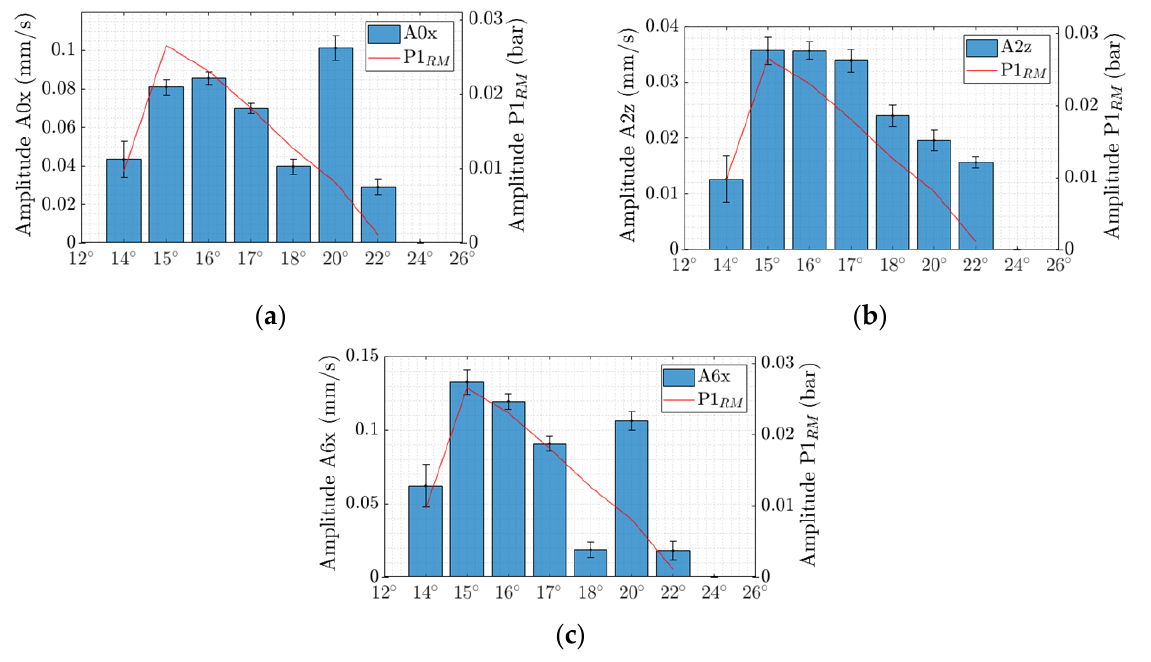
Figure 11. Velocity vibration levels at f rvr on the draft tube in radial direction for position A0x ( a ), on the spiral casing in axial direction for position A2z ( b ), and on the upper generator bearing in radial direction for position A6x ( c ) at α from 12° to 26°.